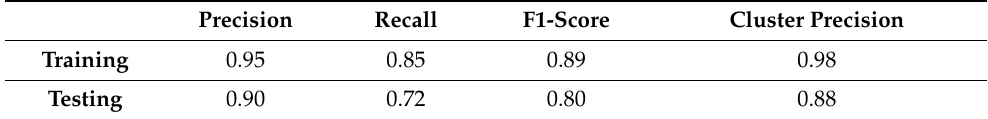
Table 1. Training and testing results for YOLOv4.